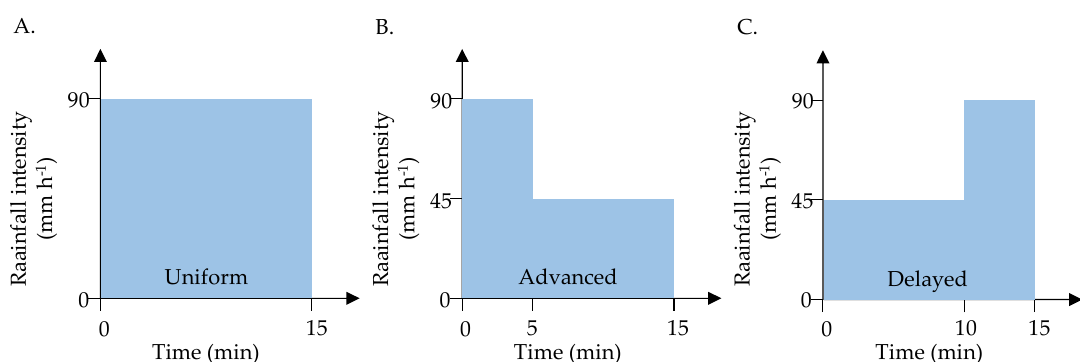
Figure 3. Rainfall patterns simulated in the experiments: ( A ) Uniform, ( B ) advanced and ( C ) delayed.